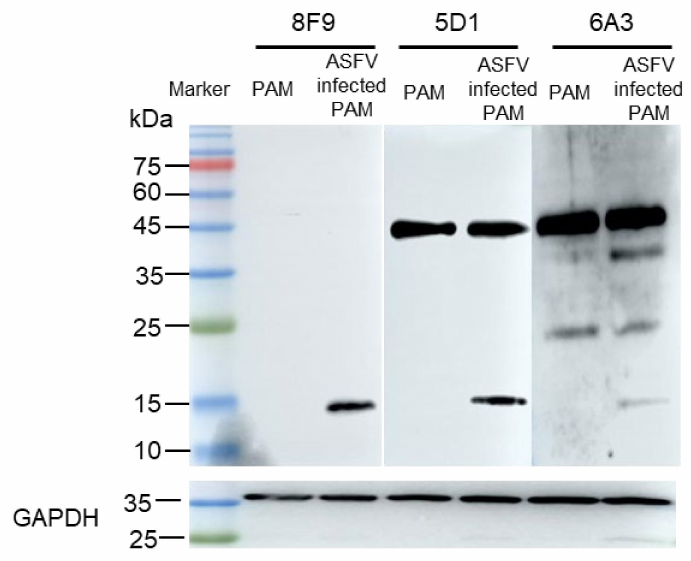
Figure 5. Antibody specificity verified by Western blotting using 8F6, 5G1, and 6A3 mAbs in PAMs and PAMs infected with